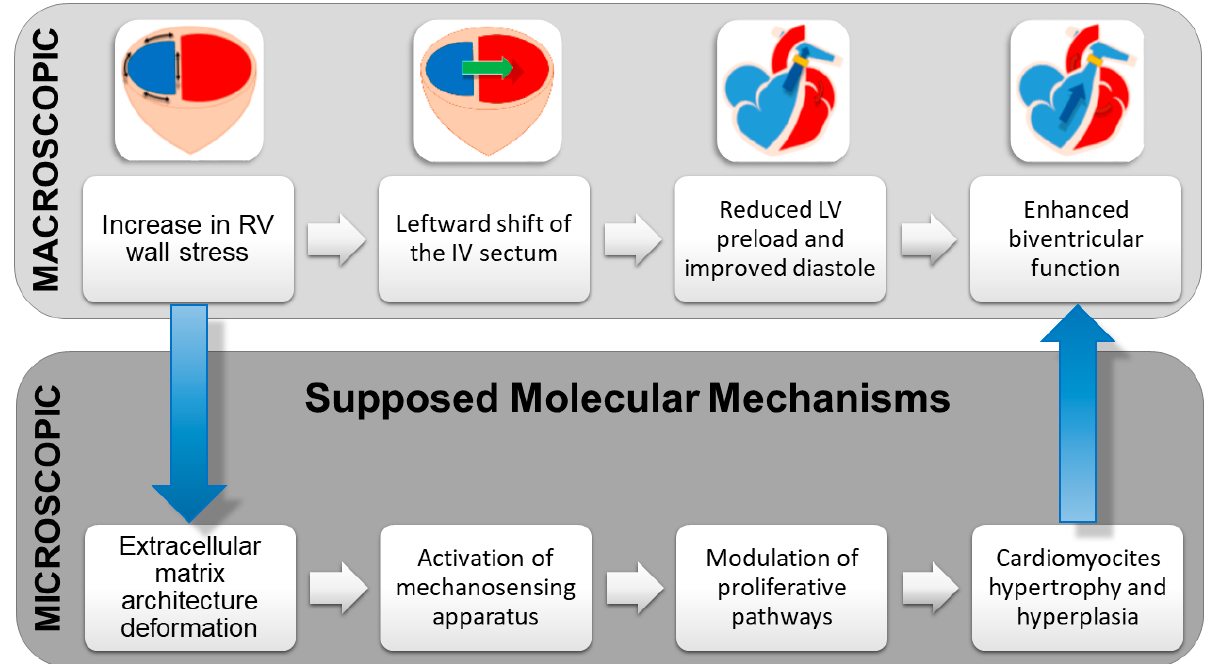
Figure 3. Functional changes induced by PAB and possible cellular and molecular correlates. IV: interventricular septum. LV: left ventricle. RV: right ventricle.